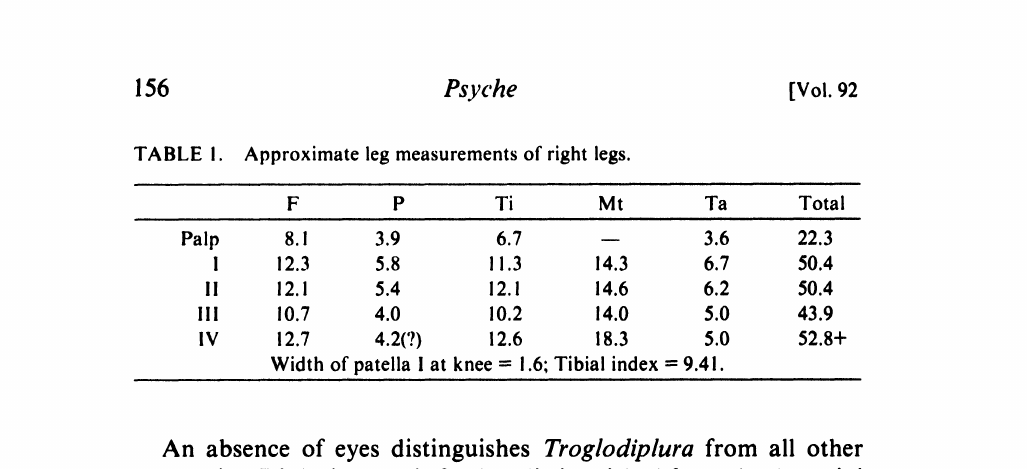
TABLE I. Approximate leg measurements of right